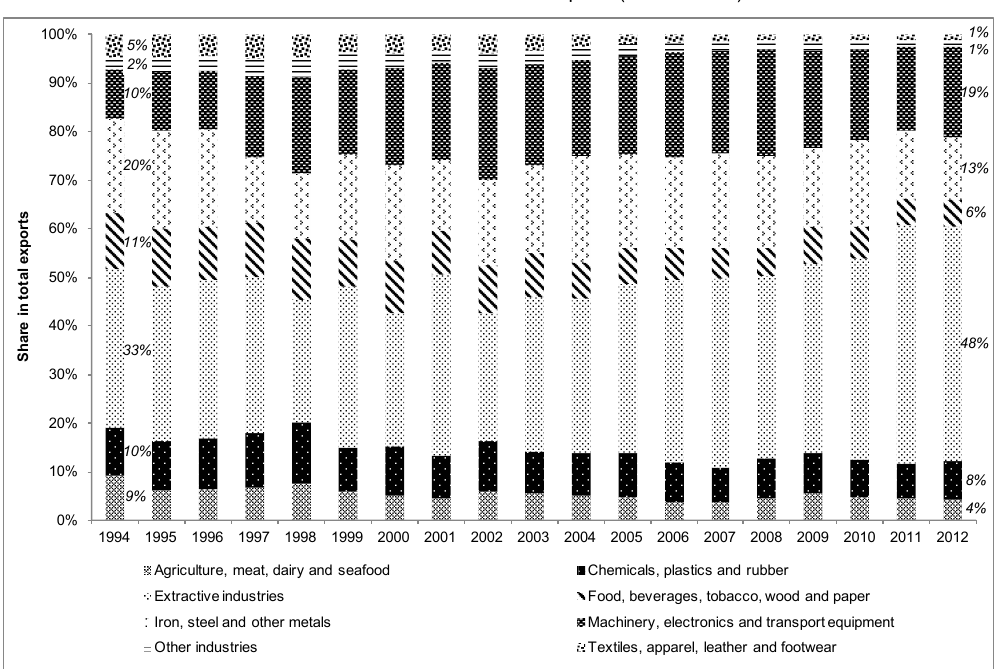
Broad structure of South Africa’s exports (1994 –